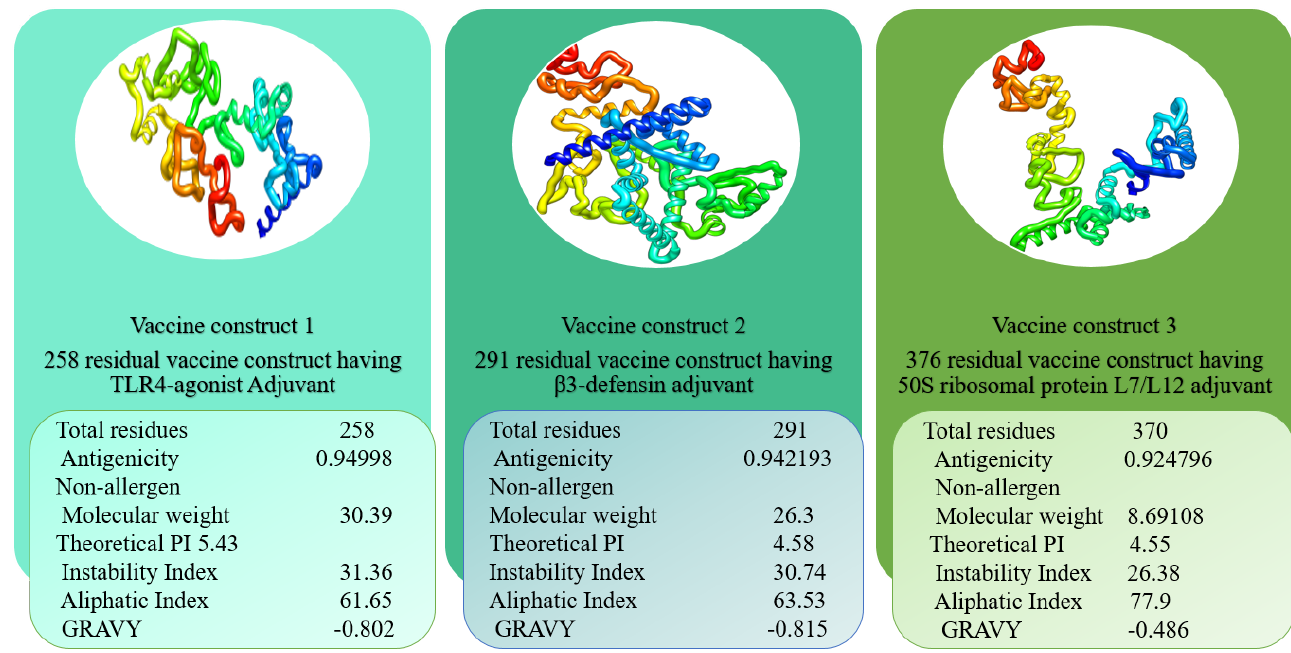
Figure 6. Vaccine constructs with different three types of adjuvants. Table 2. Physical parameters for validation of final subunit vaccine constructs.